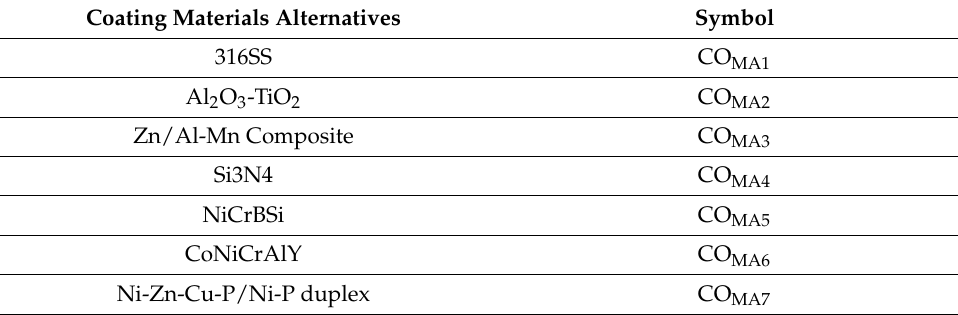
Table 15. Alternatives of coating materials for magnesium alloy.